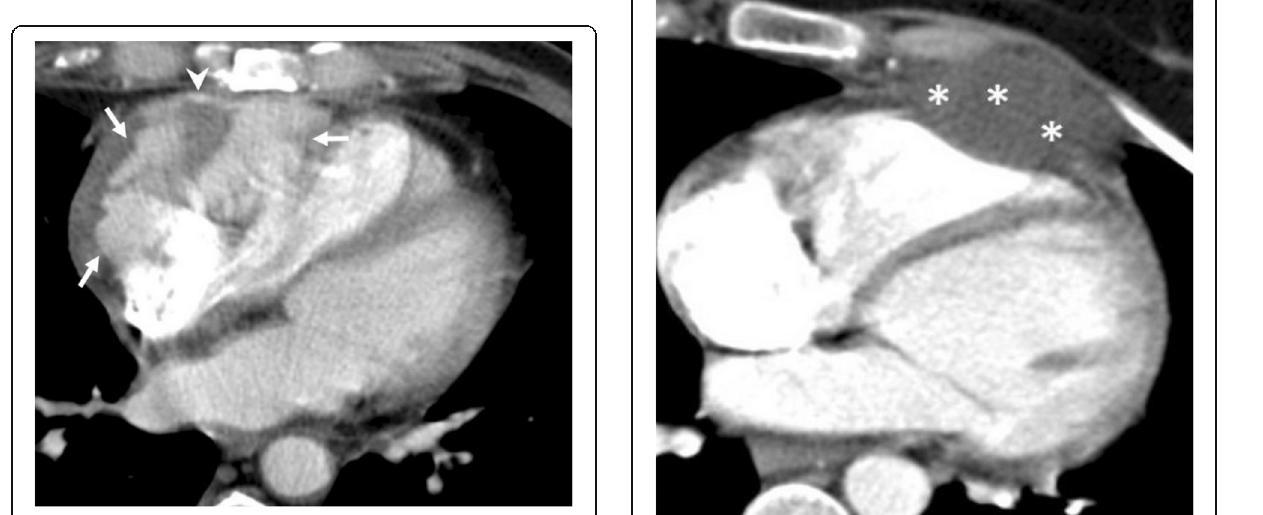
Fig. 15 A 59-year-old man with pathologically proven primary cardiac angiosarcoma. Axial contrast-enhanced CT image reveals a highly vascular mass (arrows) invading the right atrioventricular groove, right atrium, and ventricle. Pericardial involvement (arrowhead) is also noted